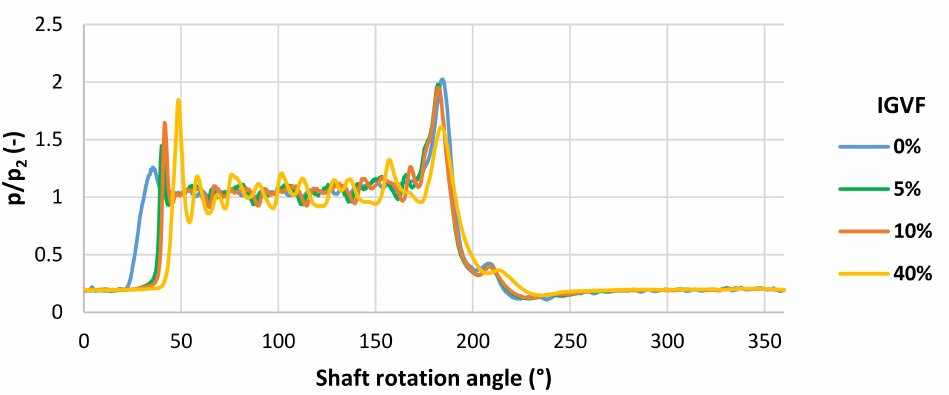
Figure 26. Displacement chamber pressure profiles for the IGP obtained from the CFD simulations at